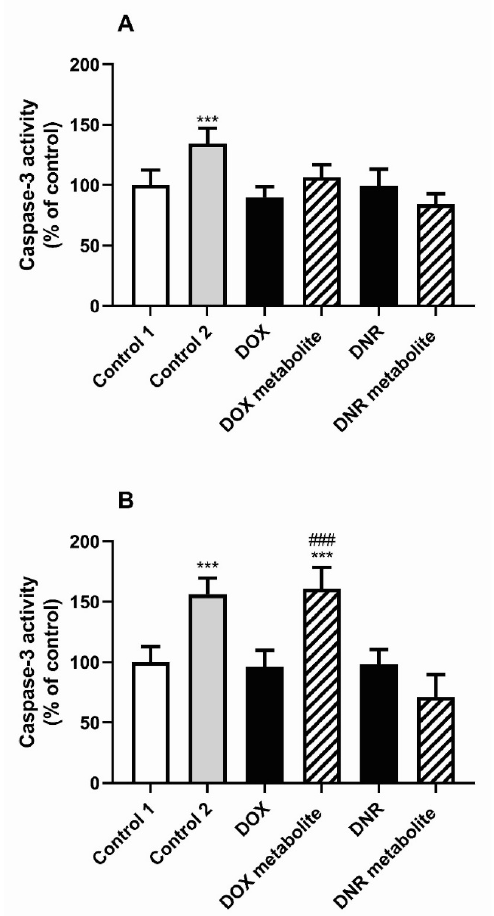
Figure 5. The effect of conditioned media on the caspase-3 activity after 24 h ( A ), and 48 h ( B ) in BJ fibroblasts: *** p < 0.001 versus the control 1 cultures. ### p < 0.001 versus the cell espoused to me-